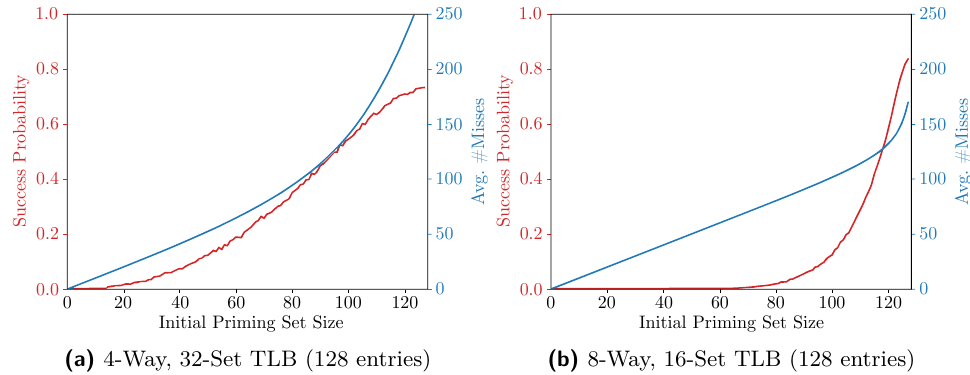
Figure 9: Catching probability and average number of misses for the prime and prune steps as a function of the initial probing set size for finding one translation conflict using the Prime+Prune+Probe attack. The modeled TLB uses the RPLRU replacement policy. It implements index-randomization but does not re-randomize the mapping during the